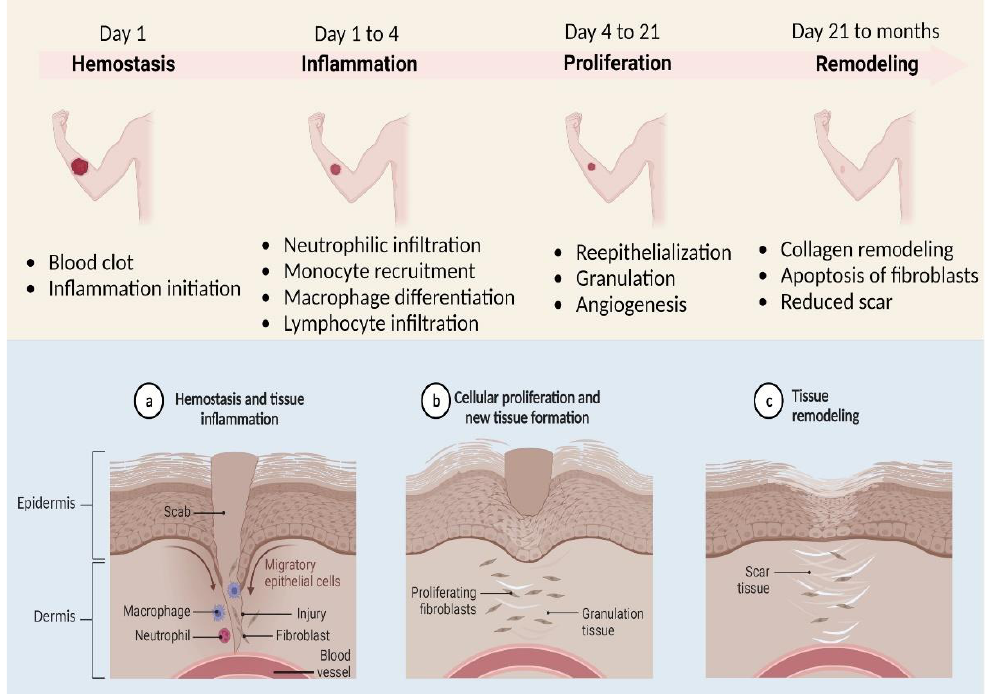
Figure 1. A diagrammatic illustration of the basic steps of cutaneous wound healing.